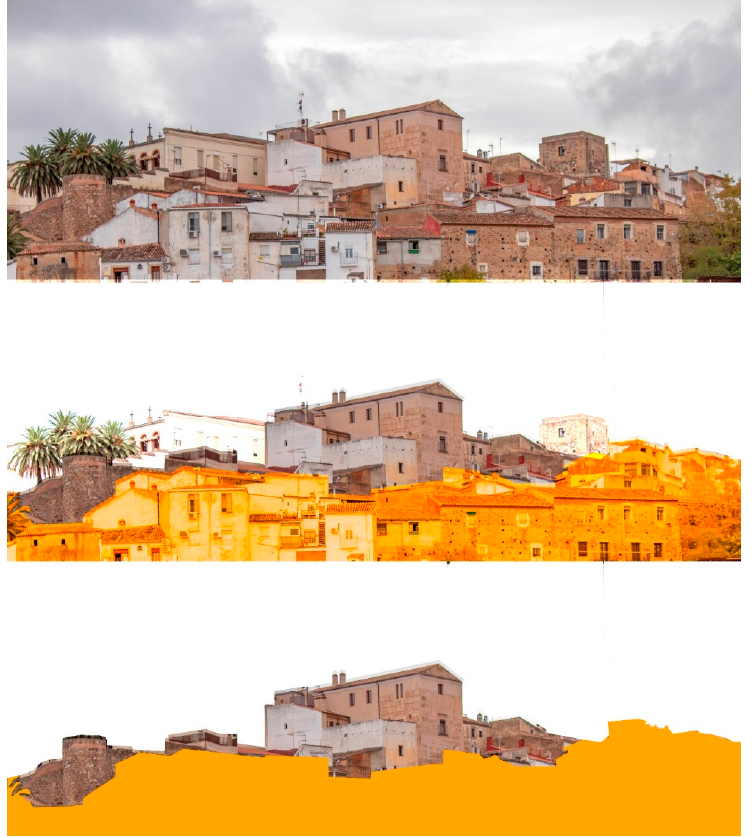
Figure 4. Location of the intervention within the defensive line currently absorbed by the existing buildings. View from the surroundings of the Rivera del Marco.